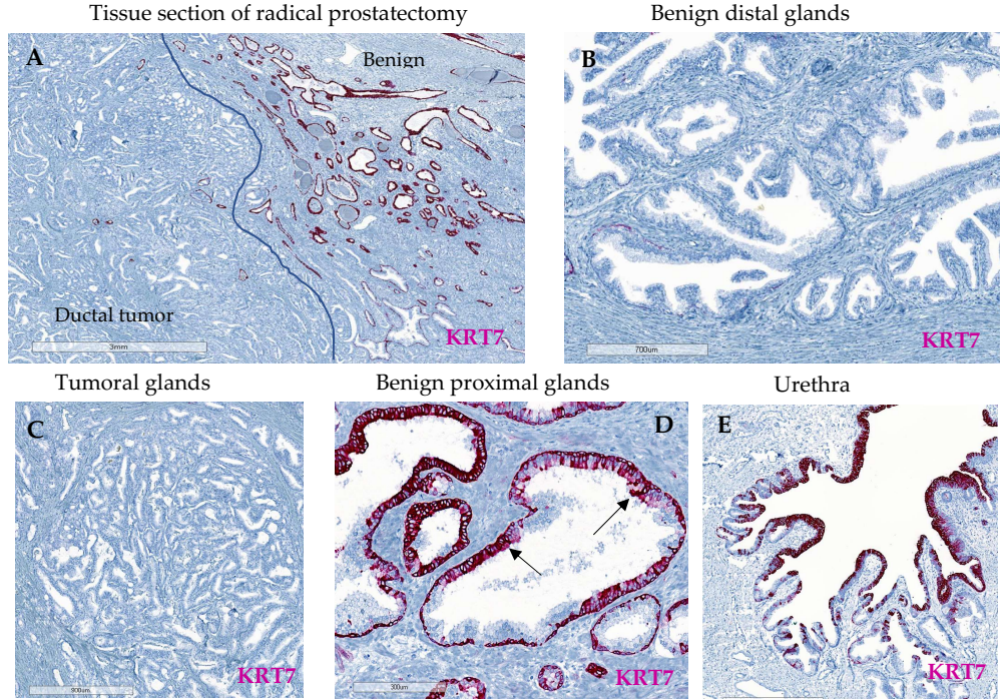
Figure 2. Examples of KRT7 staining by immunohistochemistry (IHC) using KRT7 rabbit SP52 clone on FFPE prostatic tissues section of radical prostatectomy from a patient (Patient #1) with prostatic acinar and ductal carcinoma. ( A , D ) The KRT7 staining was found augmented in peri- tumoral benign glands proximal to the tumor (blue line defining the separation between tumor and benign peri-tumoral glands), ( A , C ) but negative inside the tumor, ( B ) and decreased in benign glands located distally. ( D ) After magnification, positive KRT7 staining was confirmed mainly in the basal compartment from benign proximal peri-tumoral glands, with a supra-basal staining identified with arrows, ( C ) and negative in tumoral ductal glands. ( E ) Positive staining was found in cells of the urethral urothelium, as a